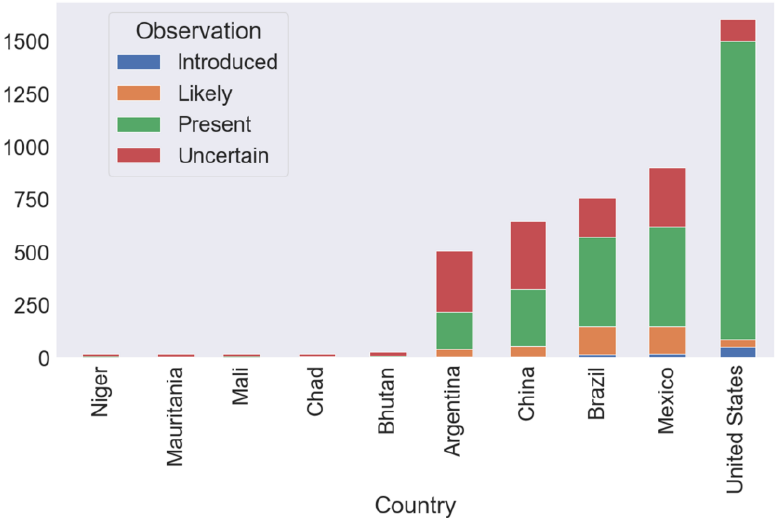
Figure 2. Total number of species records for bottom 5 countries and top 5 countries. “Introduced” means a certain species is not native but has been migrated or carried by human activity to that country. “Likely” means the ant species probably exist in that country. “Present” means the ant species has been observed and recorded in that country. “Uncertain” means the ant species has not been confirmed in that country. These are four data categories according to the AntWiki database.